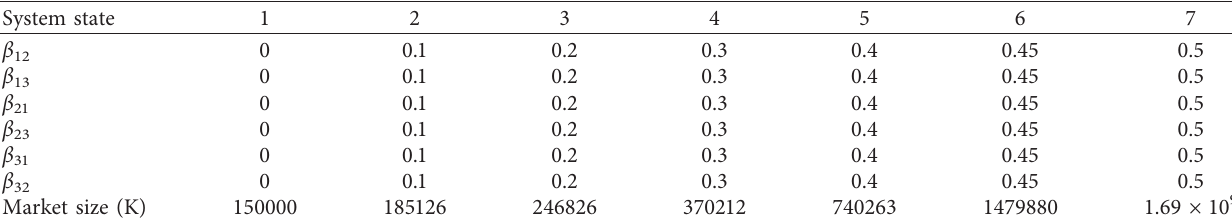
Table 8: Sensitivity analysis of the proposed model by changing β